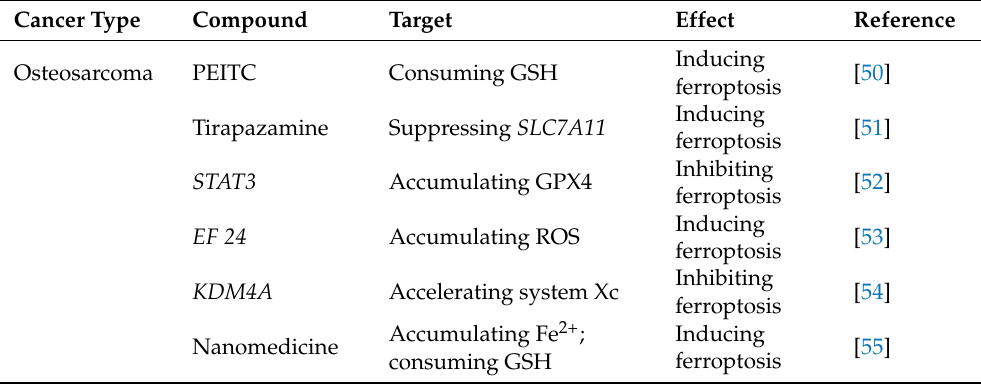
Table 2. Ferroptosis and osteosarcoma.